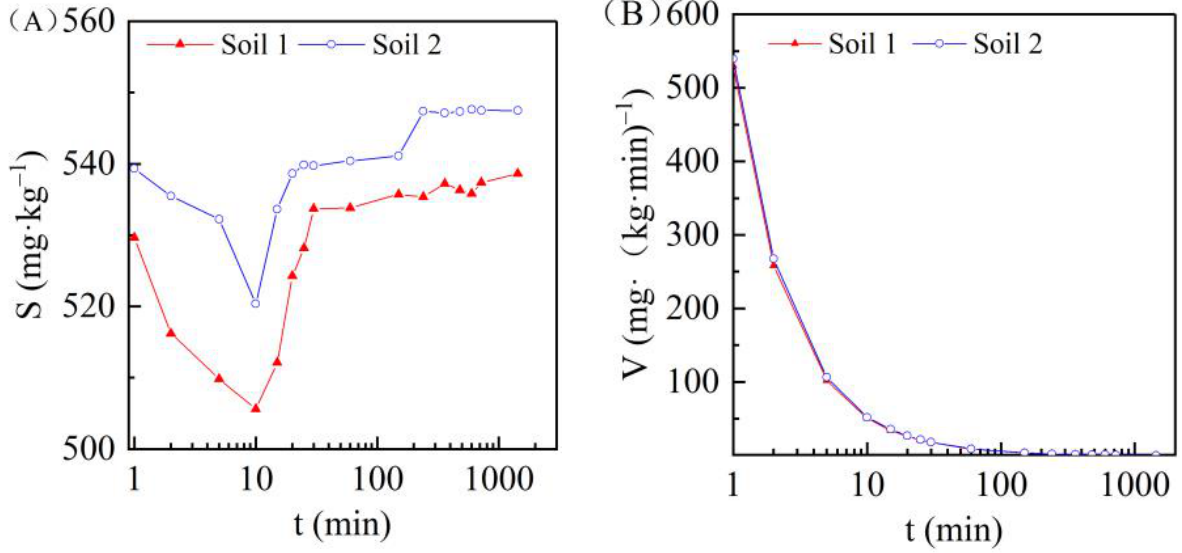
Figure 5. The oscillation time t affected the cadmium adsorption capacity S ( A ) and adsorption rate V ( B ) of the two soils.